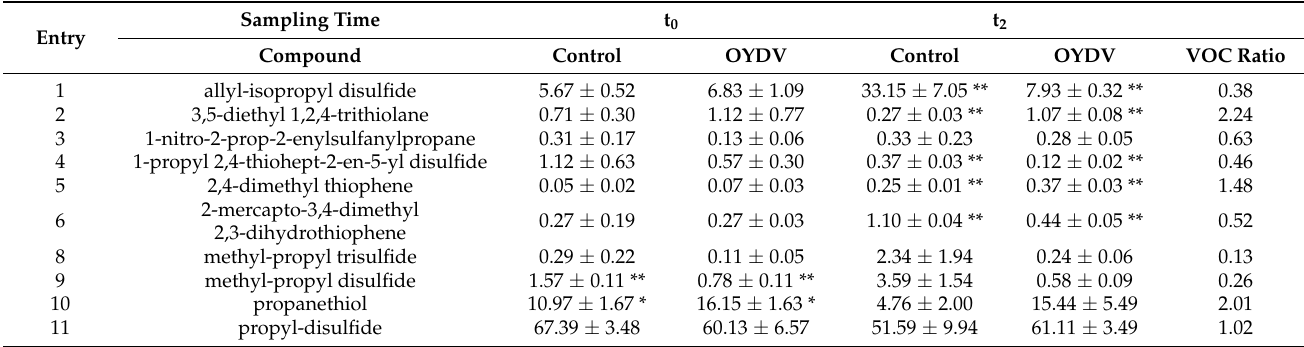
Table 3. Quantitation data (adimensional measure) of compounds in healthy and OYDV-infected bulbs at two sam- pling